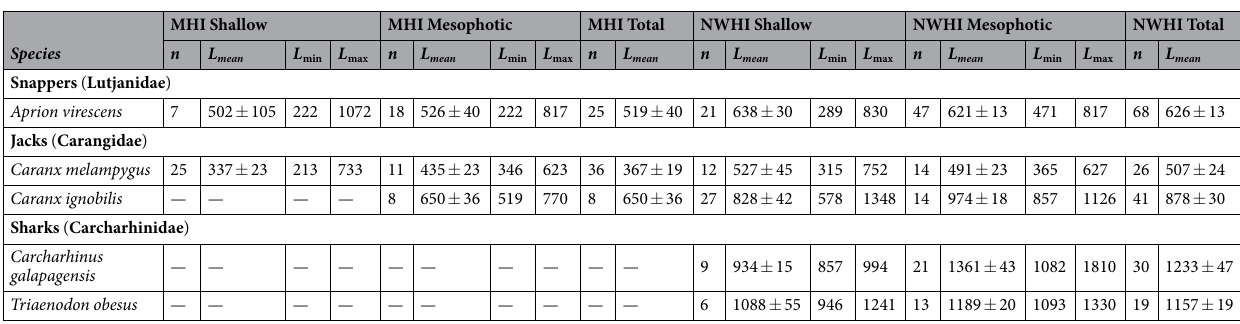
Table 5. Mean average length (L mean ) and standard error ( ± ) for five major roving predator species in Hawaii. Minimum (L min ) and maximum (L min ) lengths are noted for each species, within each depth strata (shallow, mesophotic) and region (MHI,